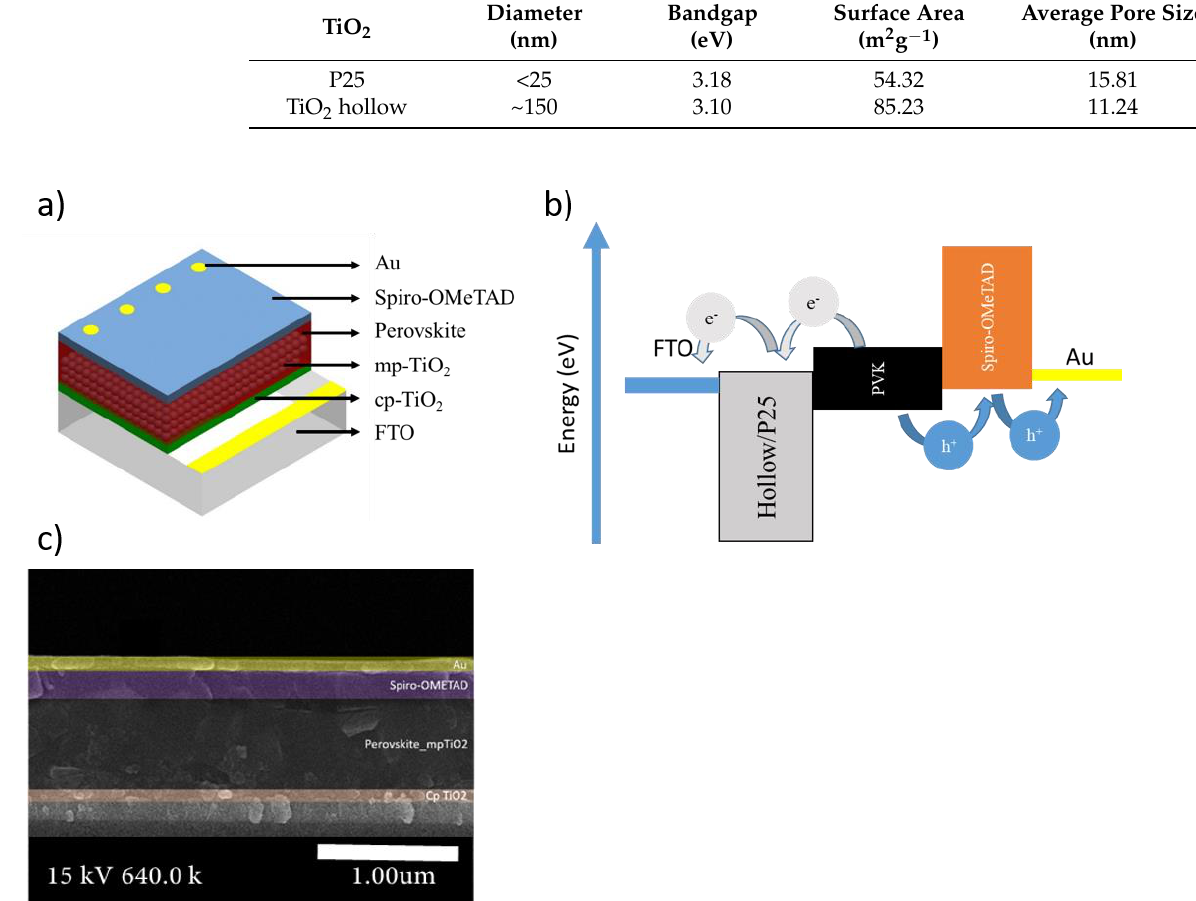
Figure 6. ( a ) The schematic of the device structure perovskite solar cells (PSCs) based on TiO 2 hollow nanospheres. ( b ) The schematic diagram of band alignment in the complete device. ( c ) Cross-sectional image of the PSC device.